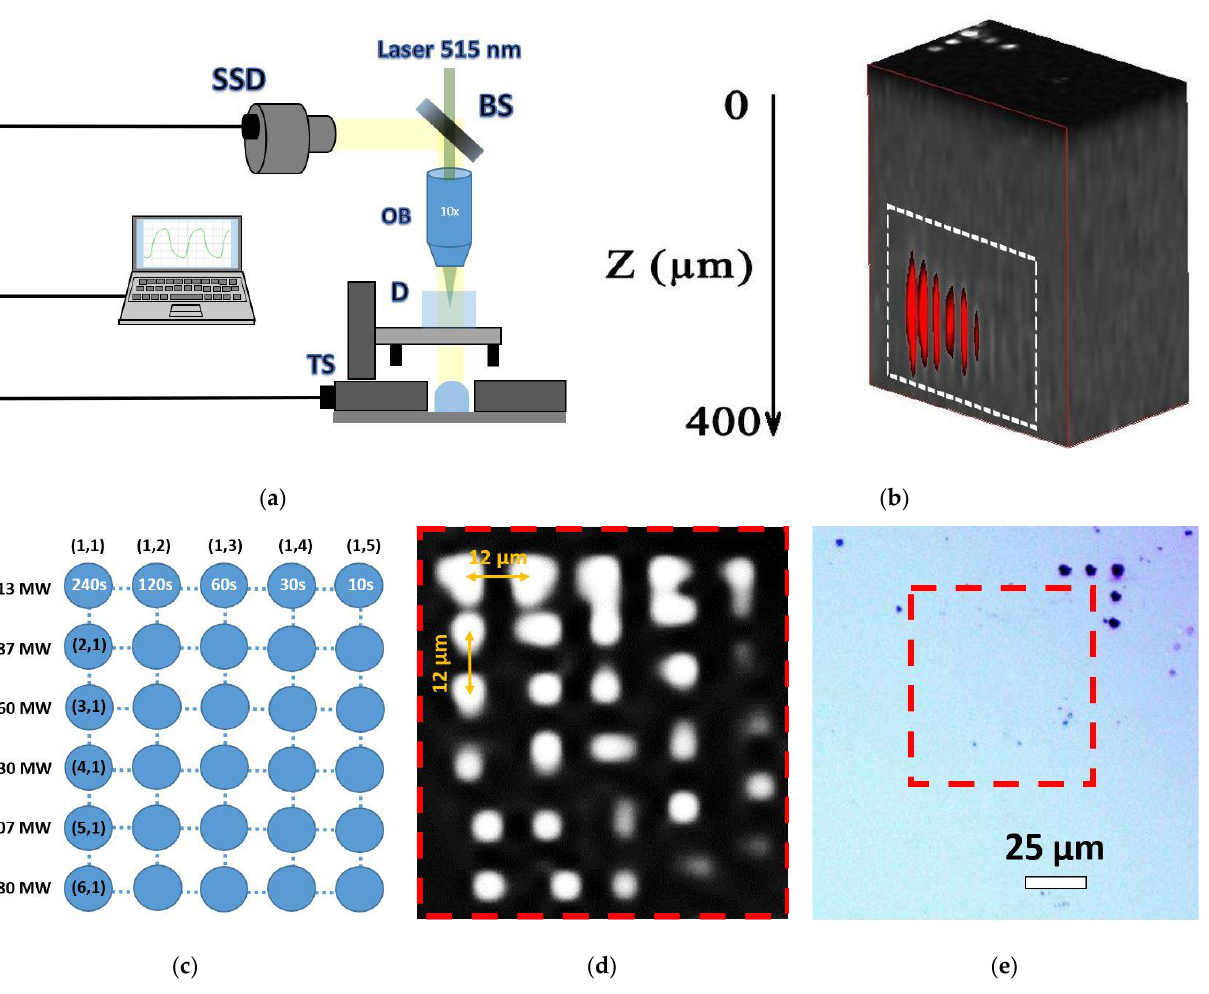
Figure 1. ( a ) Scheme of workstation for direct writing of micromarks inside the natural diamond by 515 nm, 0.3 ps laser pulses: BS—beam splitter, OB—0.25 NA micro-objective lens, D—diamond sample, CCD—CCD camera, TS—3D translation stage. ( b ) The 3D reconstruction of the inscribed region with micromarks (white area, red stripes) visualized by 3D confocal Raman microscope at 405 nm laser pump wavelength. The depth ( left axis) varies in the range of 0–400 µ m. ( c ) Schematic of micromark array with corresponding inscription parameters (peak laser power P ≈ 0.8–2.1 MW, peak fluence—2–5.5 J/cm 2 , peak intensity—7–18 TW/cm 2 , exposure time T ≈ 10–240 s, (1 − 24) × 10 6 pulses). ( d )